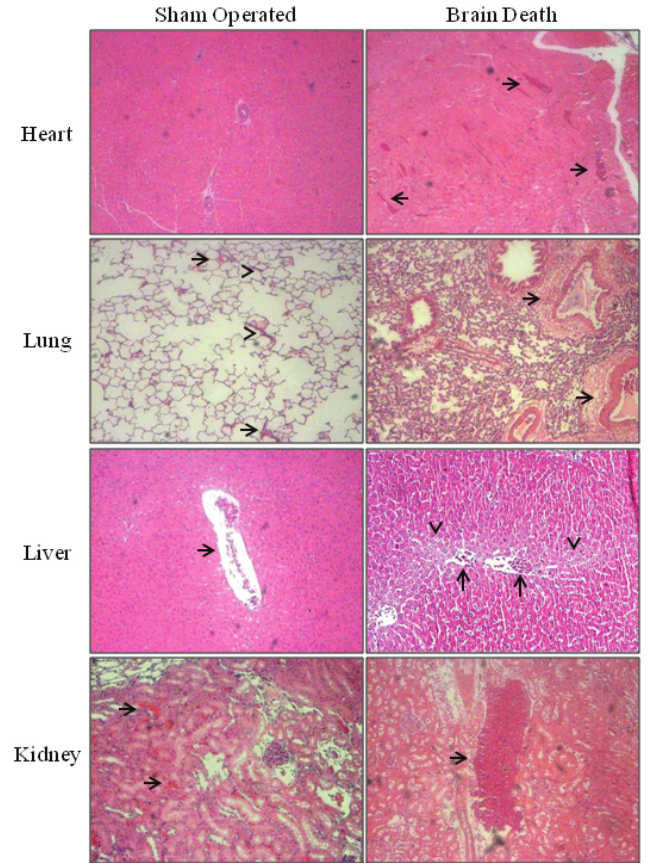
FIGURE 2 - Microphotographs of heart, lung, liver, and kidney from brain-dead (BD) and sham-operated (SH) rats. Arrows indicate vascular congestion in heart (BD), liver (BD and SH), and kidney (BD and SH). Lungs from SH rats presented vascular congestion (arrows) and alveolar thickening (arrowheads). Arrows in BD lungs indicate vascular congestion with leukocyte infiltration. In liver arrowheads indicate leukocyte infiltration (original magnification